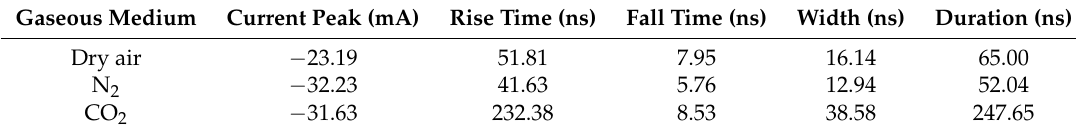
Table 2. Negative polarity current pulses